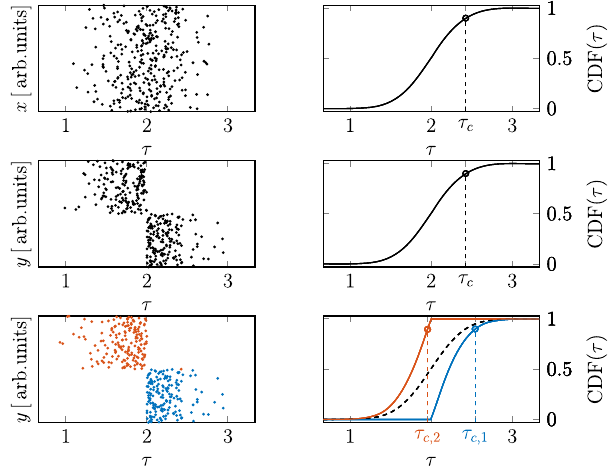
FIG. 11. Qualitative illustration of the difference between a conditional and unconditional cumulative distribution function (CDF). The upper row shows the CDF (left) of a normally distributed variable τ ð x Þ . The value of x has no impact on the distribution of τ . The distribution of τ ð y Þ (mid row) differs from τ ð x Þ , while the unconditional CDF remains unchanged. The lower row shows two conditional CDFs (blue and red) of τ ð y Þ with the correspondingly colored input samples of y